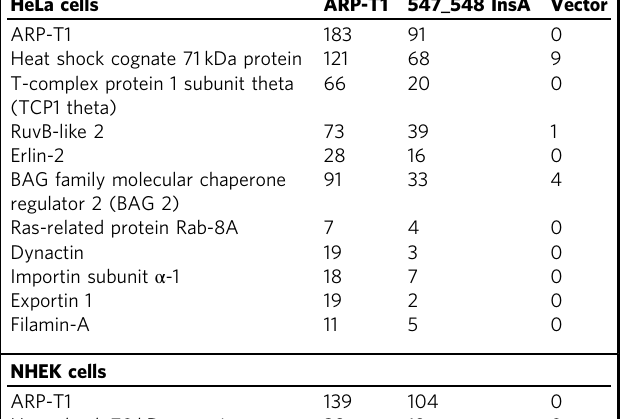
Fig. 2 ACTRT1 is regulated by non-canonical Hedgehog signaling pathway and by protein kinase C delta. a , b Relative ACTRT1, GLI1, and PTCH1 mRNA expression ( a, b N = 6) and ARP-T1 expression ( a N = 4; b N = 3) upon treatment with SAG in hTERT-RPE1 cells under proliferative ( a ) and differentiating ( b ) conditions. Actin is used as loading control for ARP-T1 expression. Numbers under the blots present the fold change expression of ARP-T1 compared to the vehicle (DMSO) treatment. c – e Relative ACTRT1 ( c N = 7), GLI1 ( d N = 4), PTCH1 ( e N = 3) mRNA expression and ARP-T1 expression ( c N = 4) upon treatment with purmorphamine (PUR) and/or vismodegib (VISMO) in differentiated hTERT-RPE1 cells. Tubulin is used as loading control for ARP-T1 expression. Numbers beneath the blots represent the fold change expression of ARP-T1 compared to the vehicle treatment. f , g Relative ACTRT1 mRNA expression upon treatment with different protein kinase inhibitors ( f ) or with PKC inhibitors ( g ) in differentiated NHEK ( N = 3). h Relative ACTRT1 mRNA